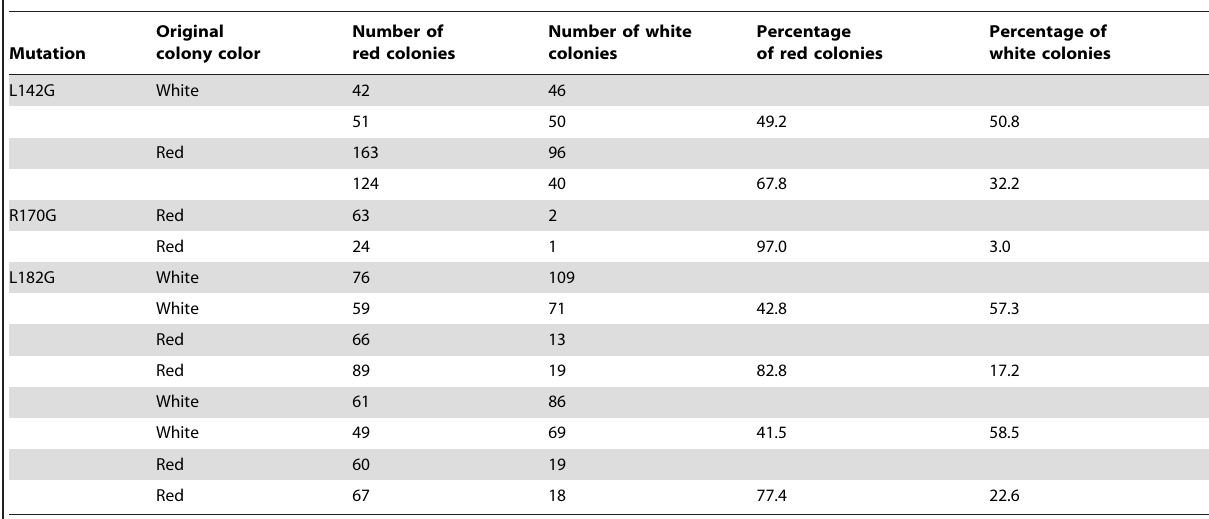
Table 1. Epigenetic switching between different expression states.